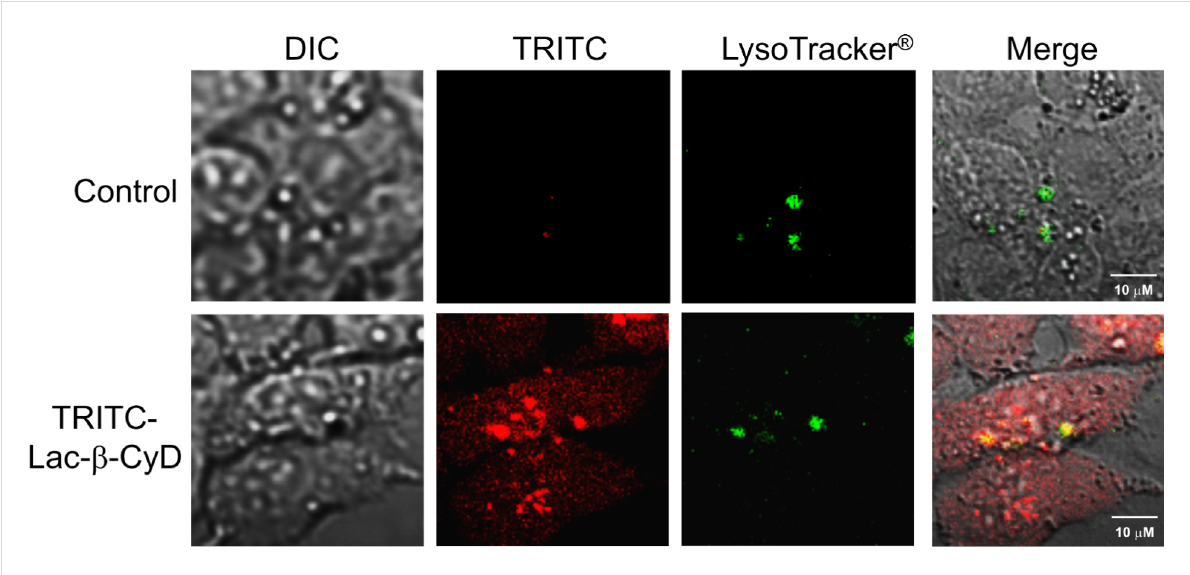
Figure 5: Intracellular distribution of TRITC-Lac- β -CyD in U18666A-treated HepG2 cells. U18666A-treated HepG2 cells were incubated in medium (FBS ( − )) with or without 100 μ M TRITC-Lac- β -CyD for 24 h. The experiments were performed independently three times, and representative images are shown.